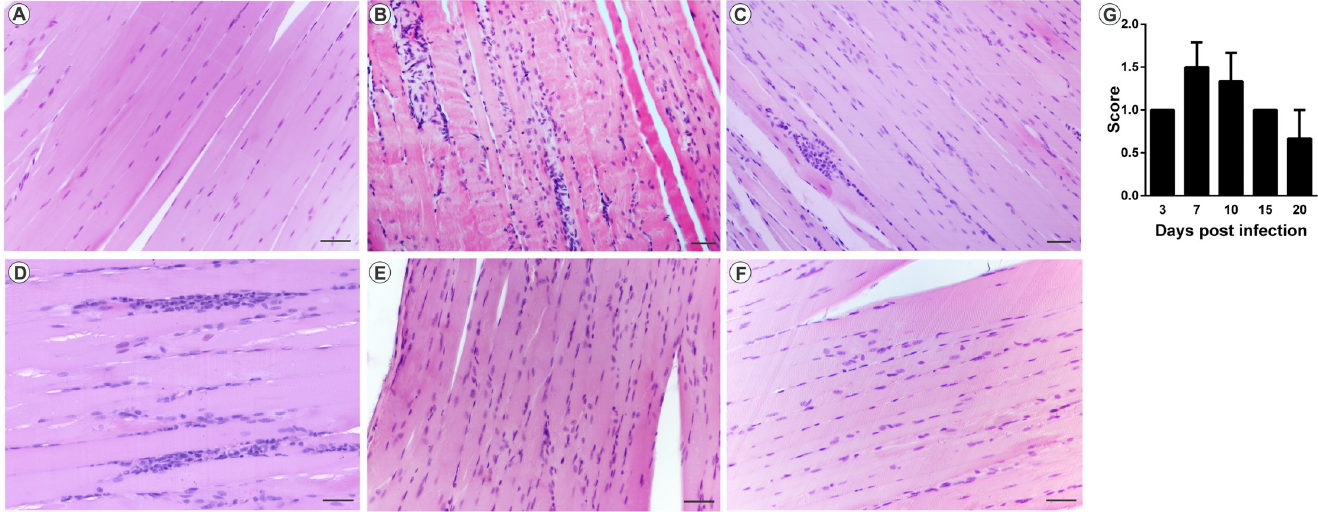
Fig 9. Mayaro virus-induced myositis in the contralateral muscle in mice infected via the rear left footpad with 2.57 x 10 6 PFU. The animals were sacrificed on days 3, 7, 10, 15 and 20 PI. for tissue damage analysis. The quadricep muscles was fixed in Karnovsky, embedded in paraffin, and 5 μ m sections were made and stained with HE. (A) Negative control. (B) MAYV infection at 3 days PI. (C) MAYV infection at 7 days PI. (D) MAYV infection at 10 days PI. (E) MAYV infection at 15 days PI. (F) MAYV infection at 20 days PI. (G) Histological score. Images (200X magnification, 40 μ m bar). N = 3 animals/group.